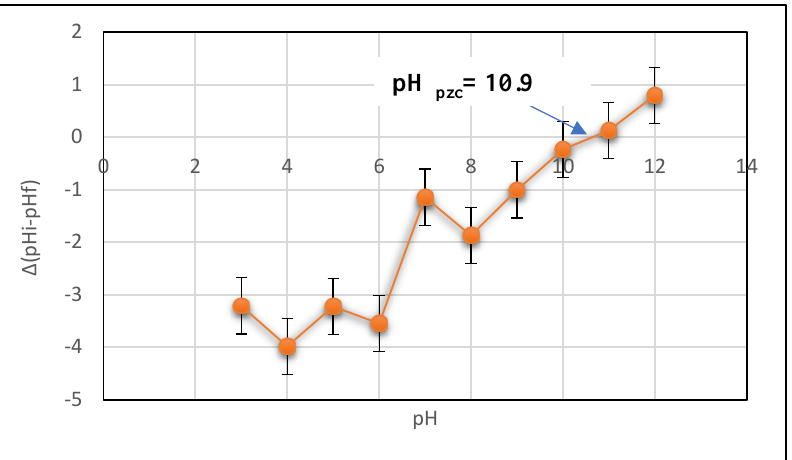
Figure 9. Point of zero charge (pH PZC ) of the Ch/g-HNTs@Zn γ M, determined by the pH drift